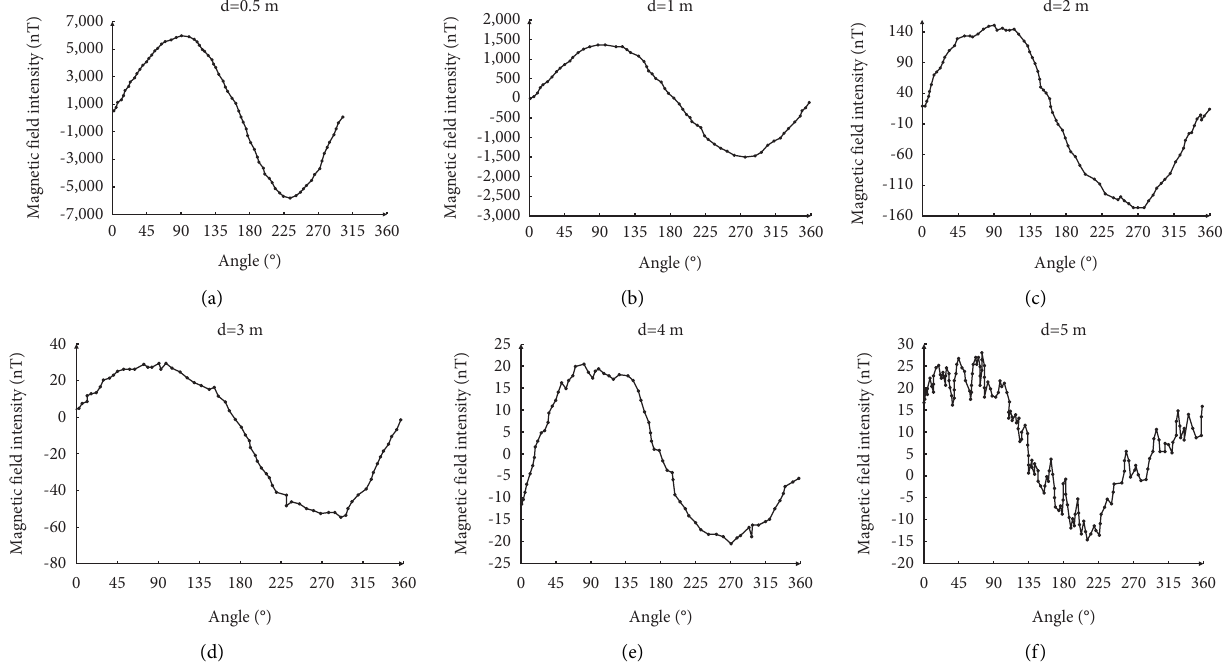
Figure 12: Calculation result of experiment point 2. (a) d � 0.5m. (b) d � 1 m. (c) d � 2 m. (d) d � 3m. (e) d � 4m. (f) d � 5